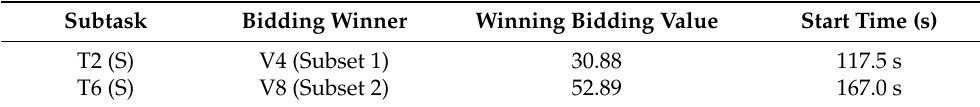
Table 10. Task assignment under the circumstance of UAV breakdown.